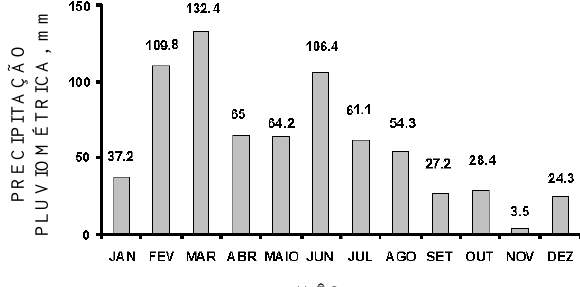
Figura 1. Precipitação pluvial ao longo do ano de 2003 no Centro Agroecológico São Miguel, no município de Esperança,